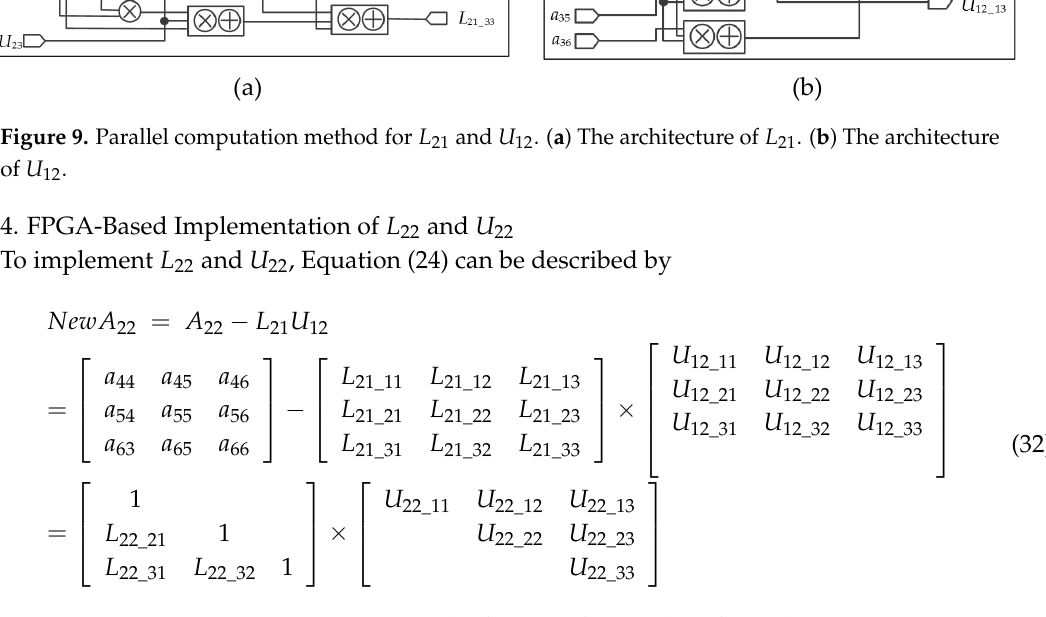
L and U . ( a ) The architecture of 21 12